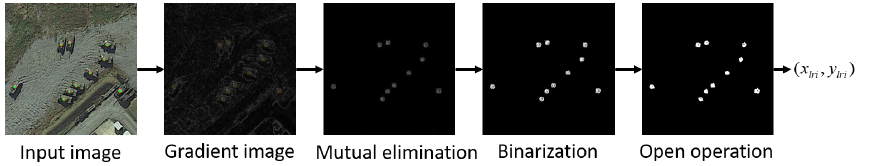
Figure 3. Adversarial patch positioning process. ( x lri , y lri ) are the coordinates of the upper left and lower right corners of the i -th adversarial patch.